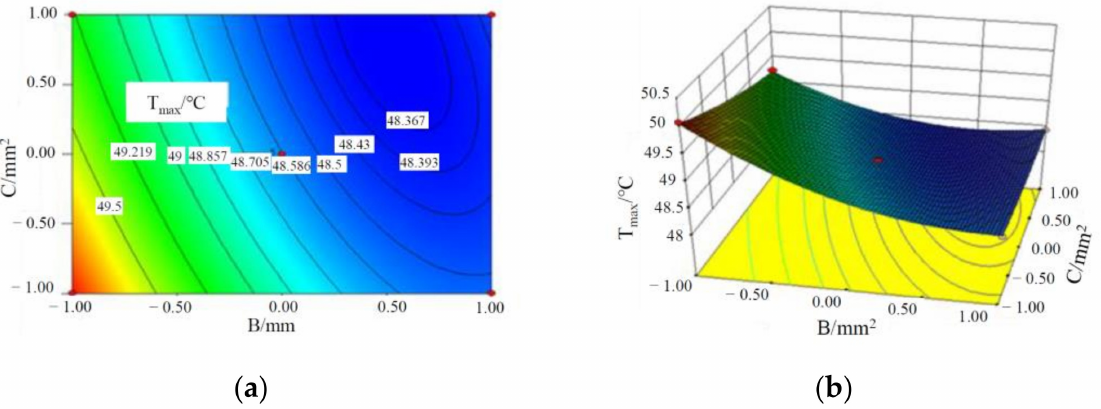
Figure 4. Contours and response surface of the impact of liquid flow rate and cross-sectional area of the pipe on the maximum temperature of a battery module. ( a ) Contours; ( b ) response